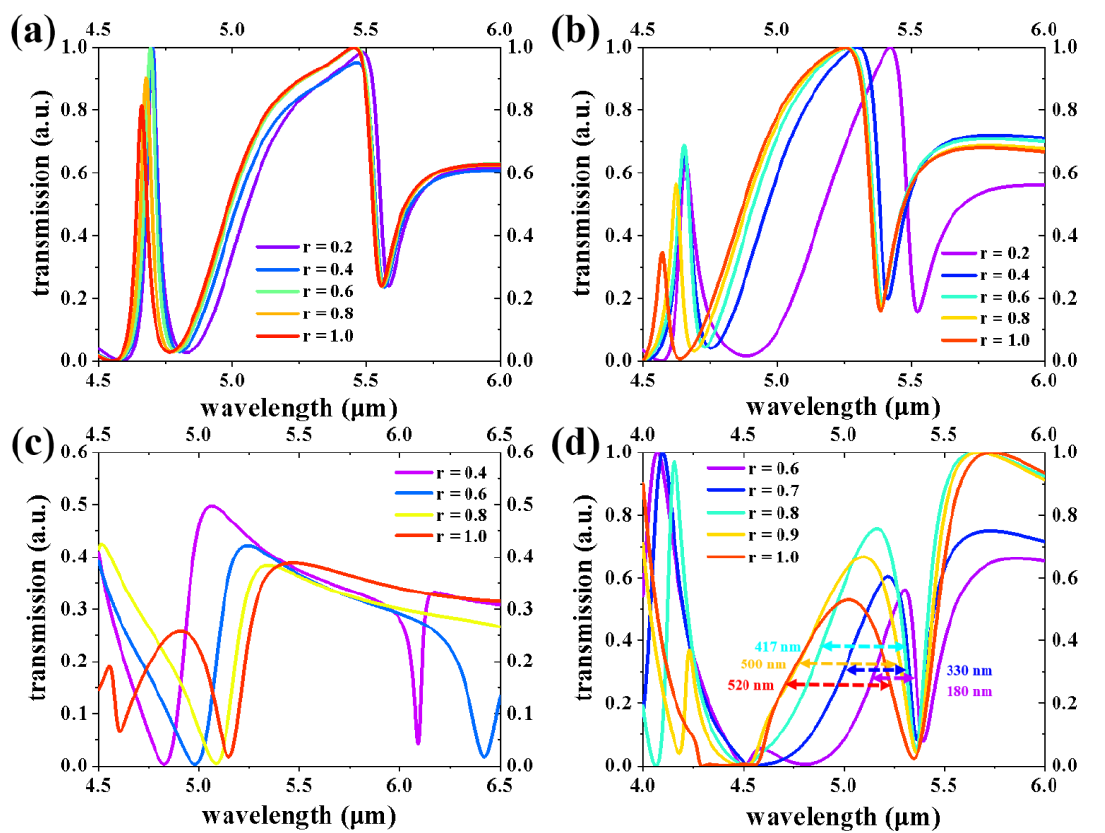
Figure 3. Transmission spectra of CSM with different r values under the conditions of ( a ) W = 200 nm, ( b ) W = 400 nm, ( c ) W = 800 nm, and ( d ) W = 1200 nm, respectively.